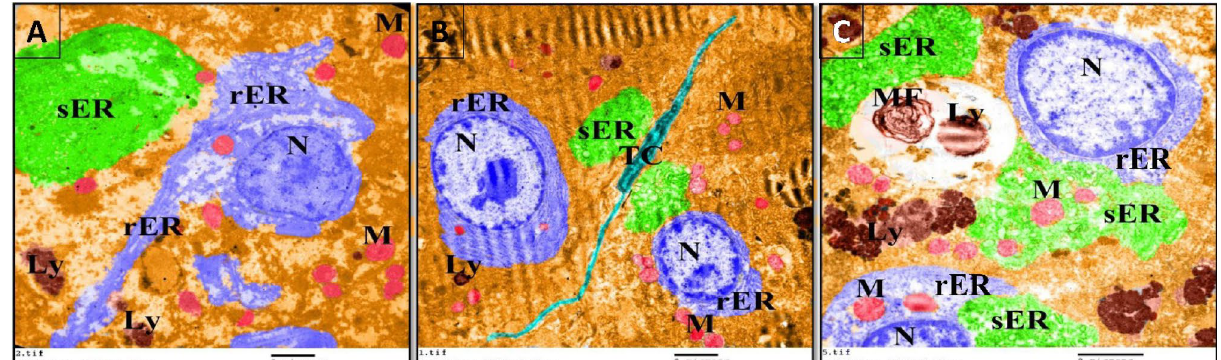
Figure 7. Colored transmission electron photomicrographs illustrating the hepatoprotective effects of NSS against 4-NP-induced hepatotoxicity in Clarias gariepinus . ( A ) Hepatocyte of the control group with euchromatic nucleus (N), well-developed rough endoplasmic reticulum (rER), well-developed smooth endoplasmic reticulum (sER), abundant mitochondria (M), and few lysosomes (Ly). ( B ) Hepatocyte of the 4-NP-intoxicated group displaying euchromatic nucleus (N), a small amount of rough endoplasmic reticulum (rER), smooth endoplasmic reticulum (sER), small sized mitochondria (M), and a small number of lysosomes (Ly). Note the telocyte (TC). ( C ) Hepatocyte of the NSS + 4-NP-treated group displaying euchromatic nucleus (N), rough endoplasmic reticulum (rER), smooth endoplasmic reticulum (sER), mitochondria (M), and myelin figure (MF), as well as numerous lysosomes